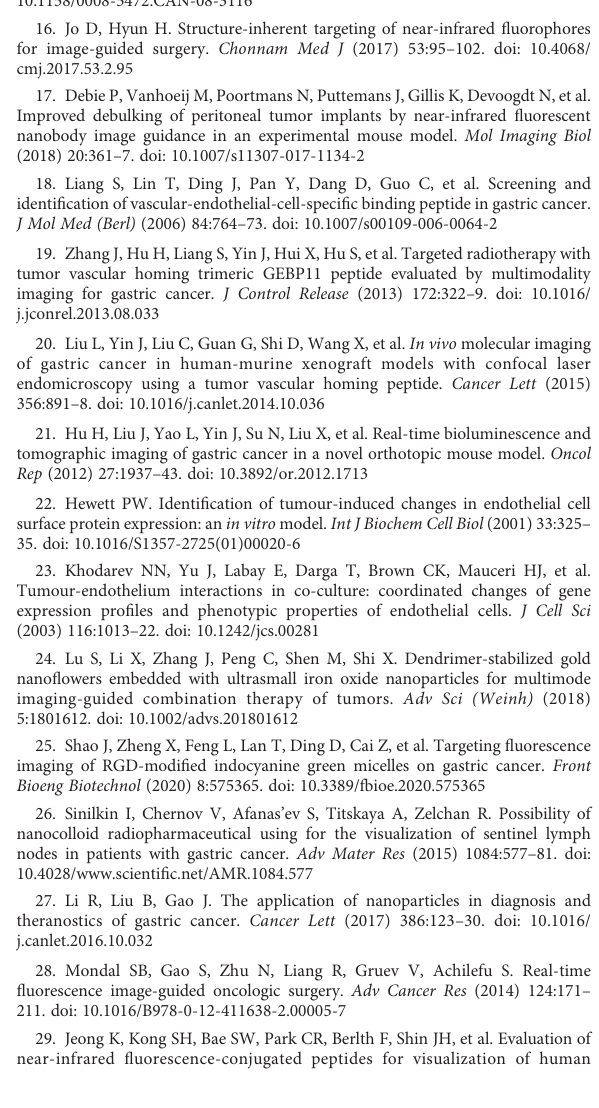
SUPPLEMENTARY FIGURE 2 Stability of GEBP11-Cy5.5 and (GEBP11) 2 -Acp-Cy5.5. In vivo binding af fi nity and targeting properties of probes with different